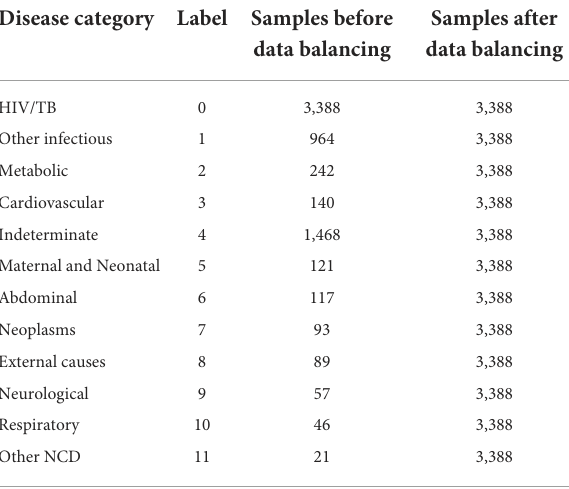
TABLE 1 Twelve disease classes and the number of data samples before and after data balancing. Class labels and corresponding number of samples Disease category Label Samples before Samples data balancing